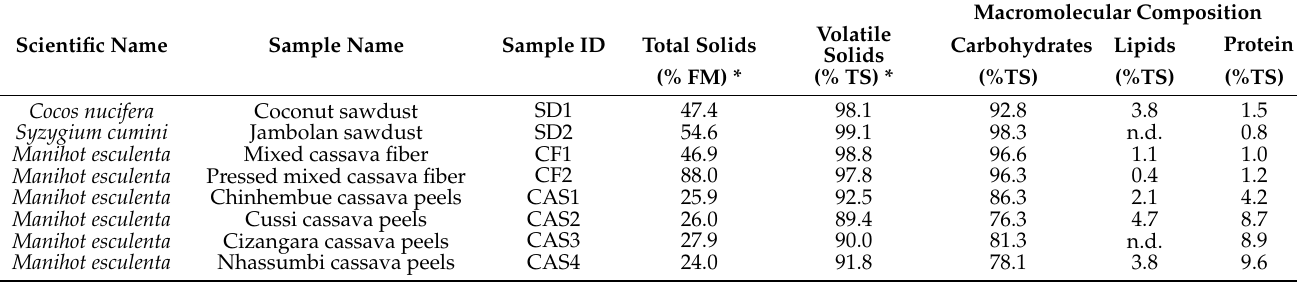
Table 1. Substrates used for this